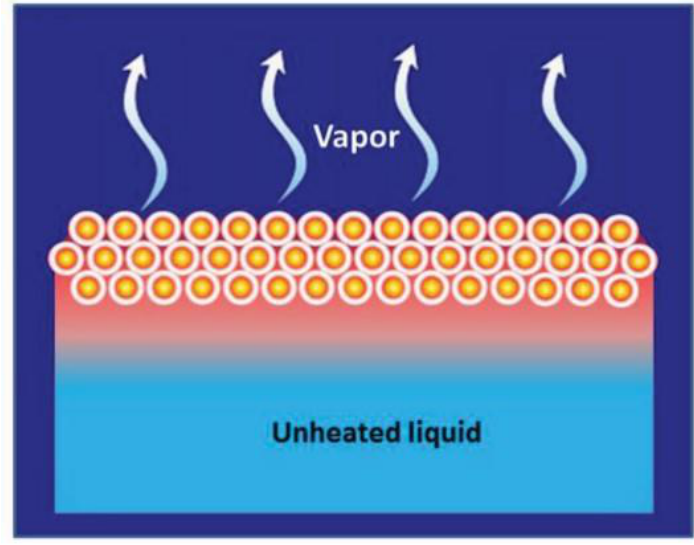
Figure 24. Schematic illustration of liquid plasmonic evaporation mechanism assisted by floating surface absorber [90]; 2014, Wiley.